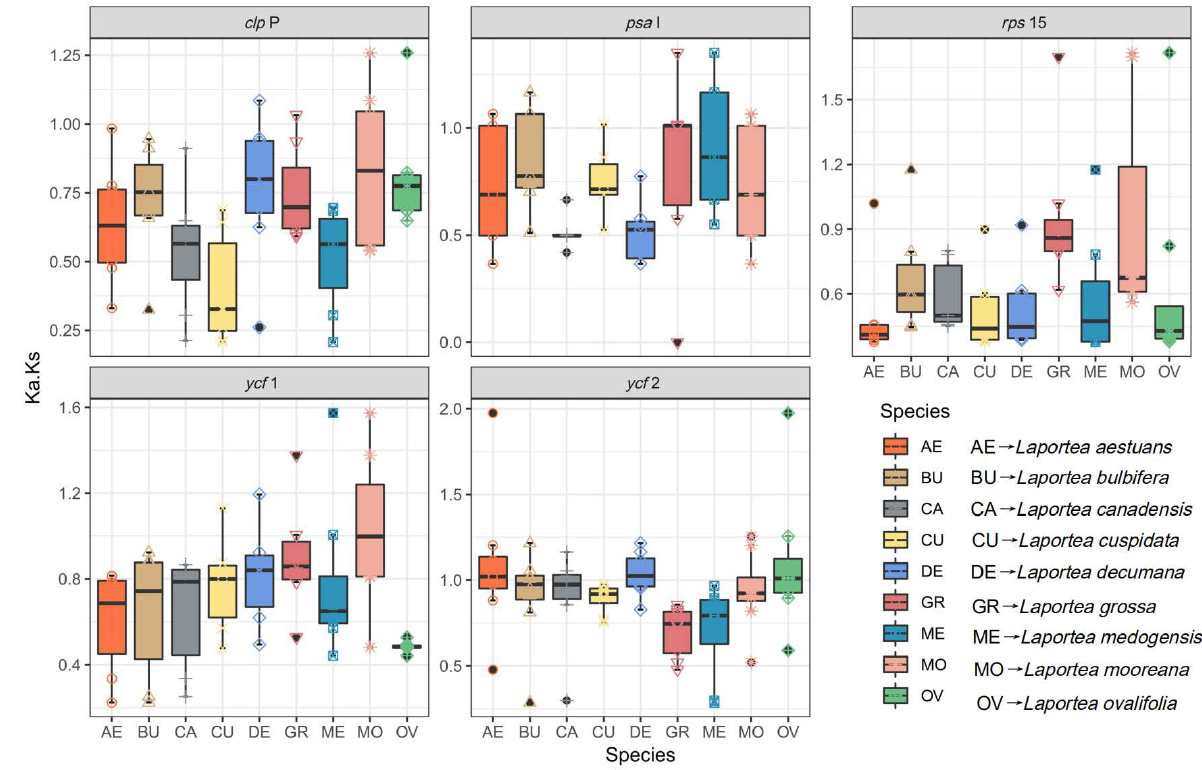
Figure 5. The dN/dS values between each plastid gene in the Laportea species are shown as box